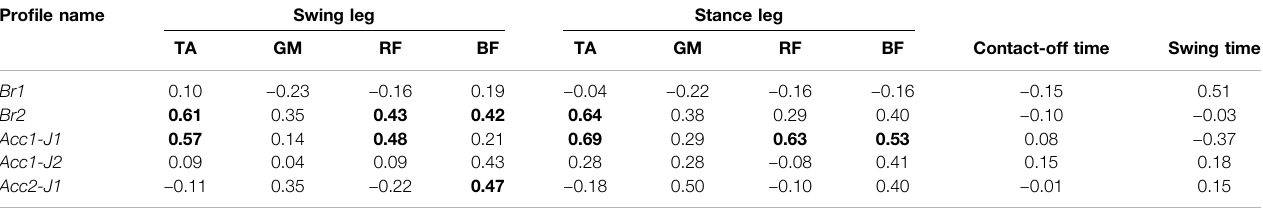
TABLE 7 | Correlations between body mass and EMG onset latencies, contact-off time and swing time in forward-direction trials. Pro fi le name